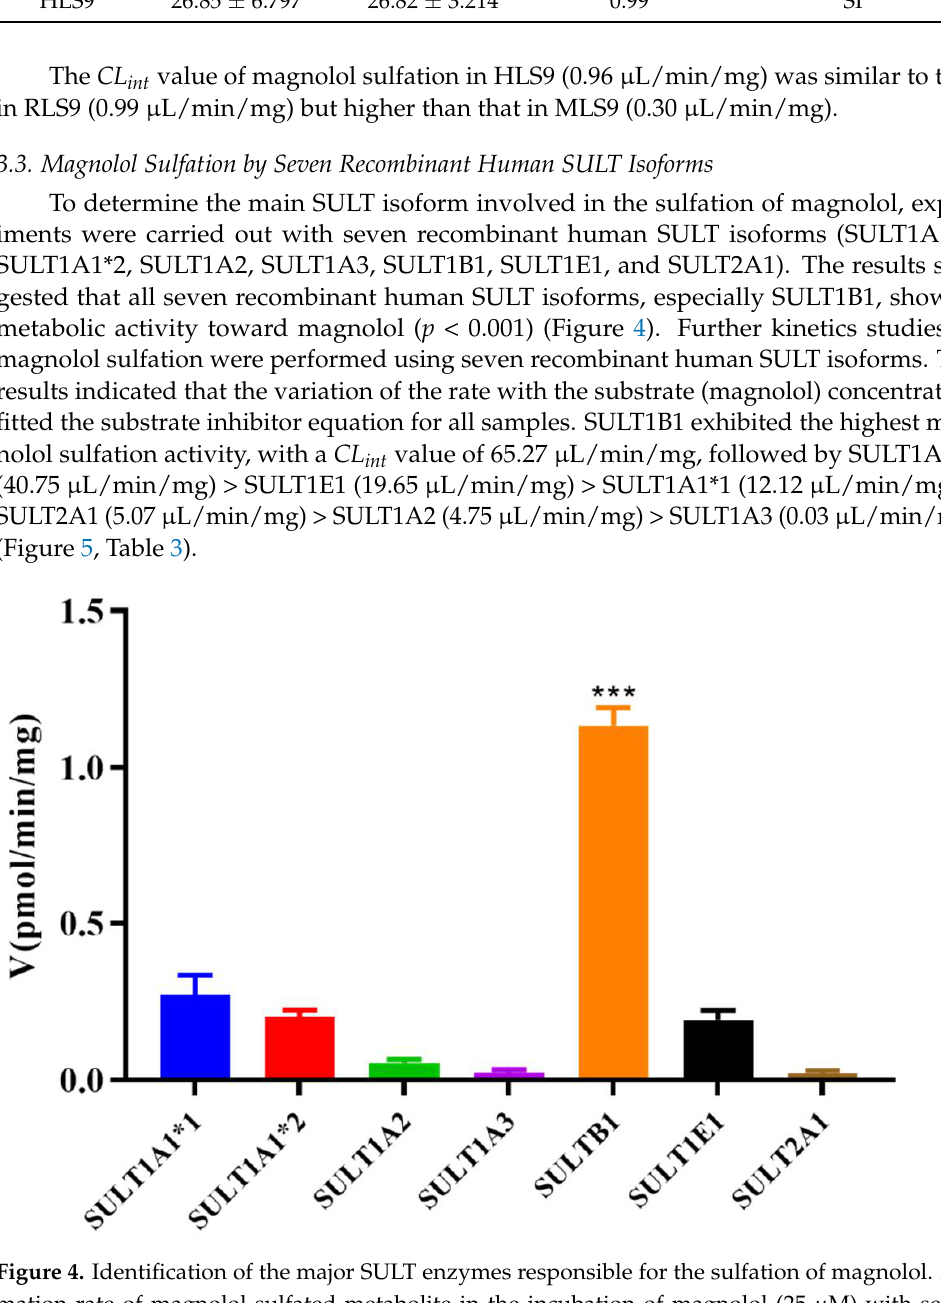
Figure 5. Enzyme kinetic analysis for the activities of the seven recombinants human SULT isoforms ( A – G ) through the magnolol substrate. Results obtained were analyzed using GraphPad Prism 7.0 software. In each figure, the inset shows the Eade–Hofstee plot. Each point is the average of three determinations, and the error bar is the standard deviation of the mean.